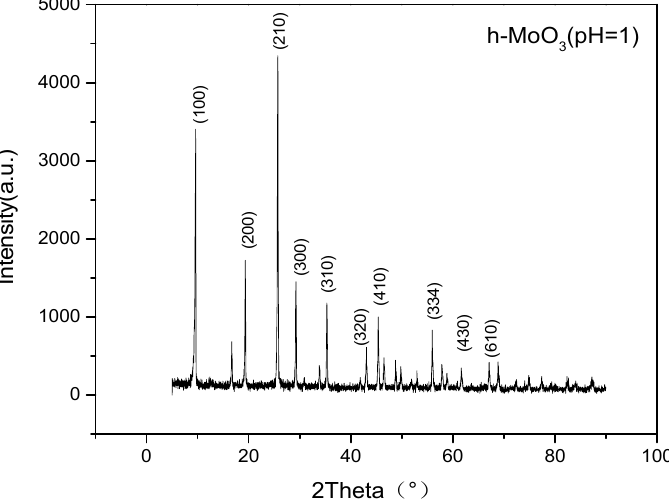
Figure 3. XRD pattern of h-MoO 3 under the optimized synthesis conditions: pH = 1, T = 90 °C, medium stirring rate (350 rpm).